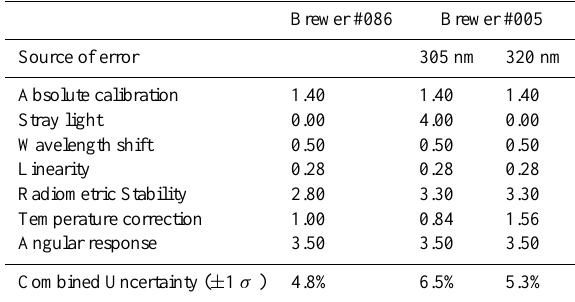
Table 1. The sources of error that affect the spectral measurements of the two Brewer spectroradiometers and the associated uncertain-